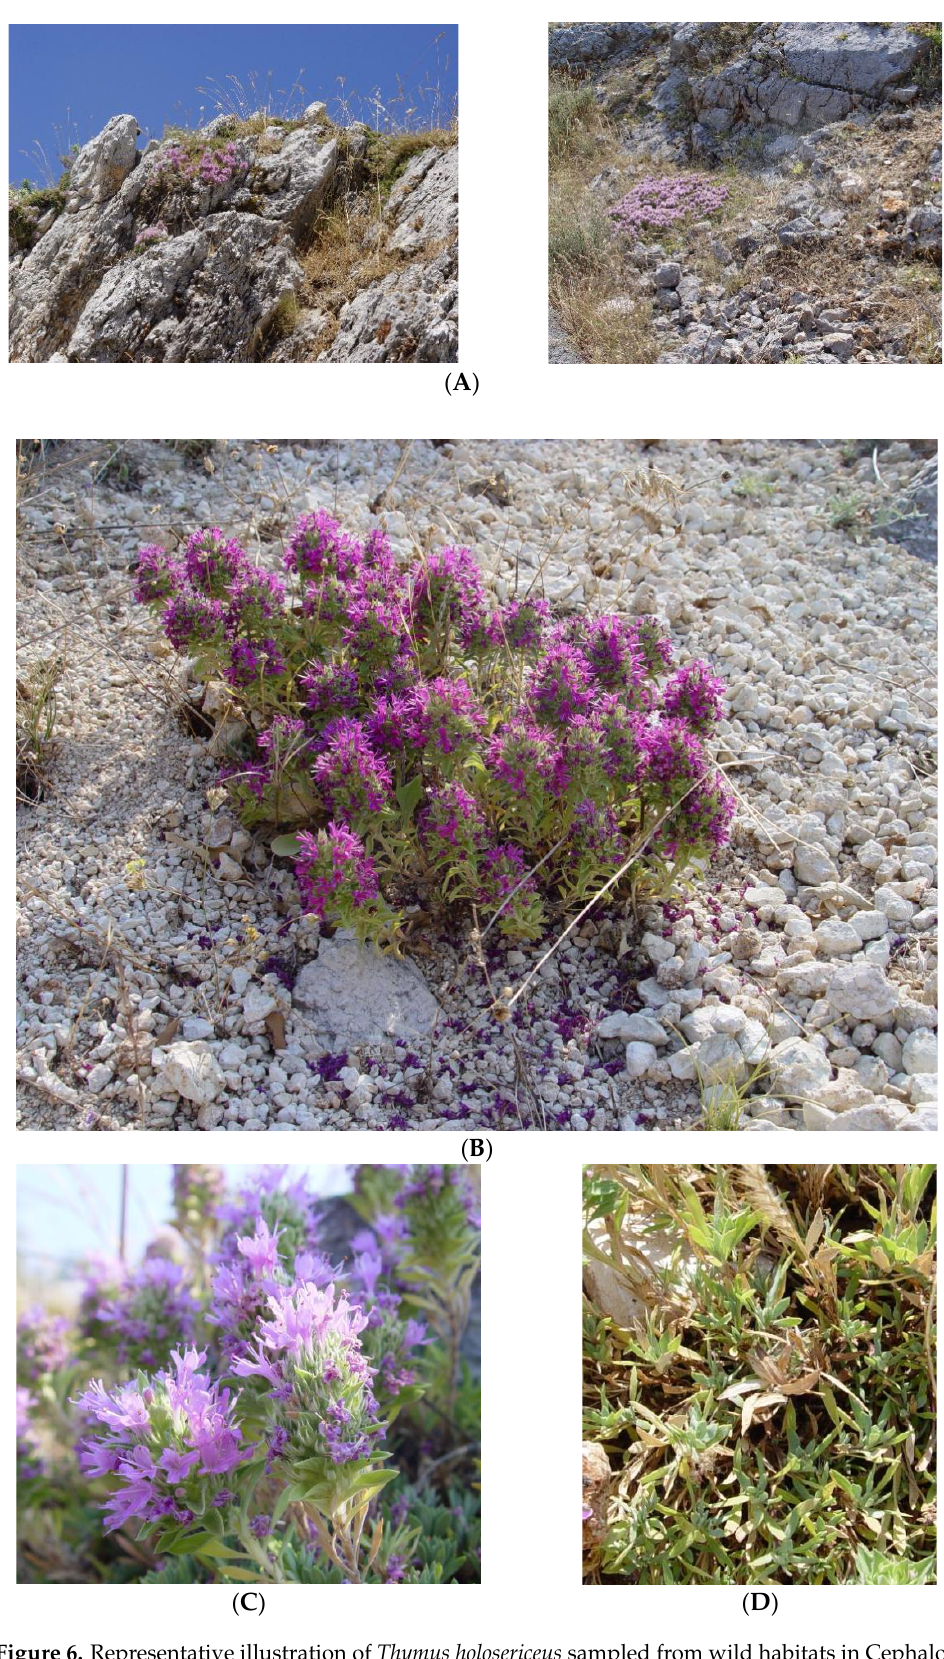
Figure 6. Representative illustration of Thymus holosericeus sampled from wild habitats in Cephalonia ( A ) and Lefkada ( B ) Islands (Greece) with variations in flower color and inflorescences ( B , C ) and typical leaves ( B , D ). Table 3. Localities collection of Thymus holosericeus from three Ionian Islands (Greece) recorded in the WGS84 coordinate system.